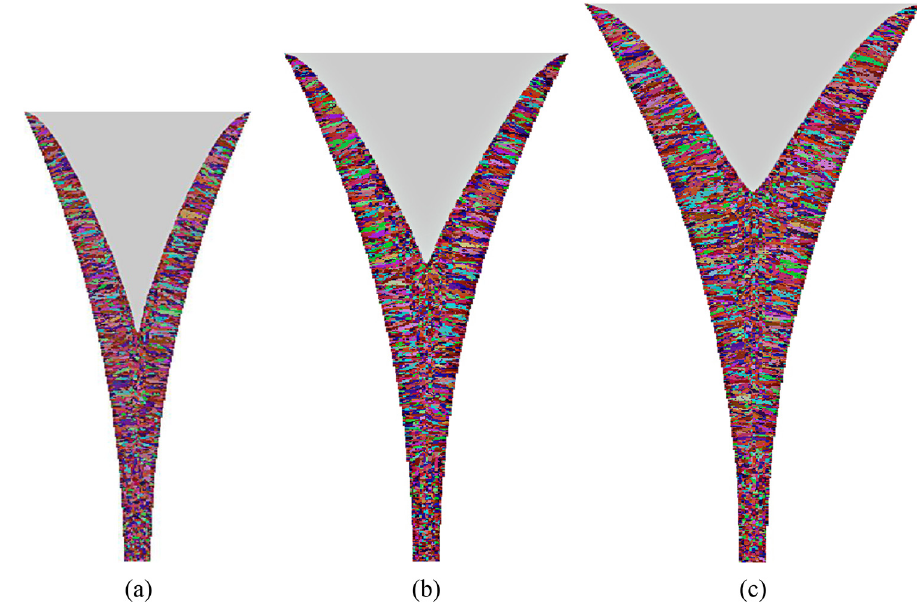
Figure 6: Solidi fi cation microstructure at di ff erent molten pool heights. ( a ) 45 mm, ( b ) 50 mm, and ( c ) 55